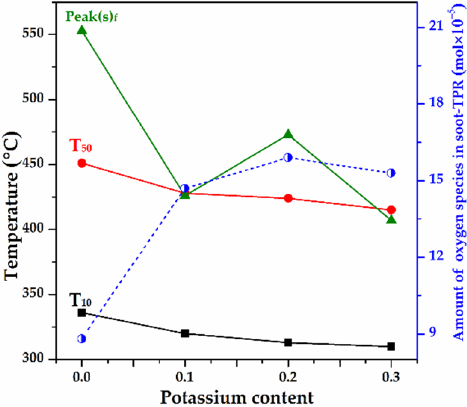
Figure 15. The relationships among catalytic performance, K content, peak temperature of soot-TPR and active oxygen in as-prepared monolith catalysts.